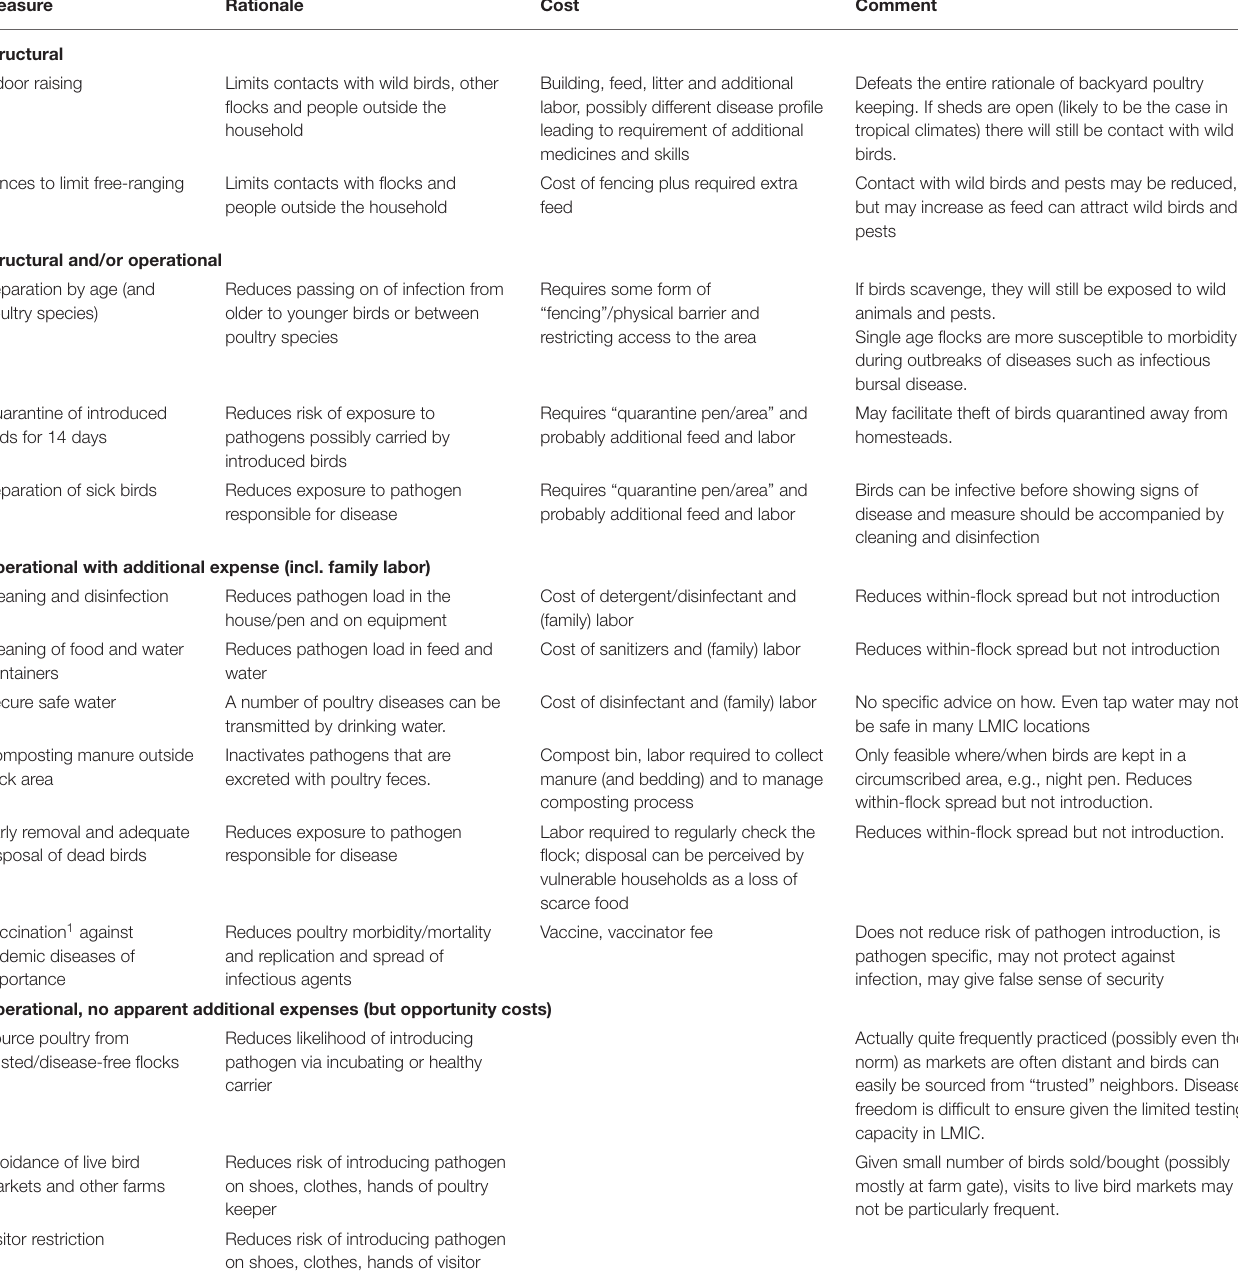
TABLE 1 | Recommended biosecurity measures for backyard/village poultry [elaborated from Conan et al. (5)], rationale, cost and